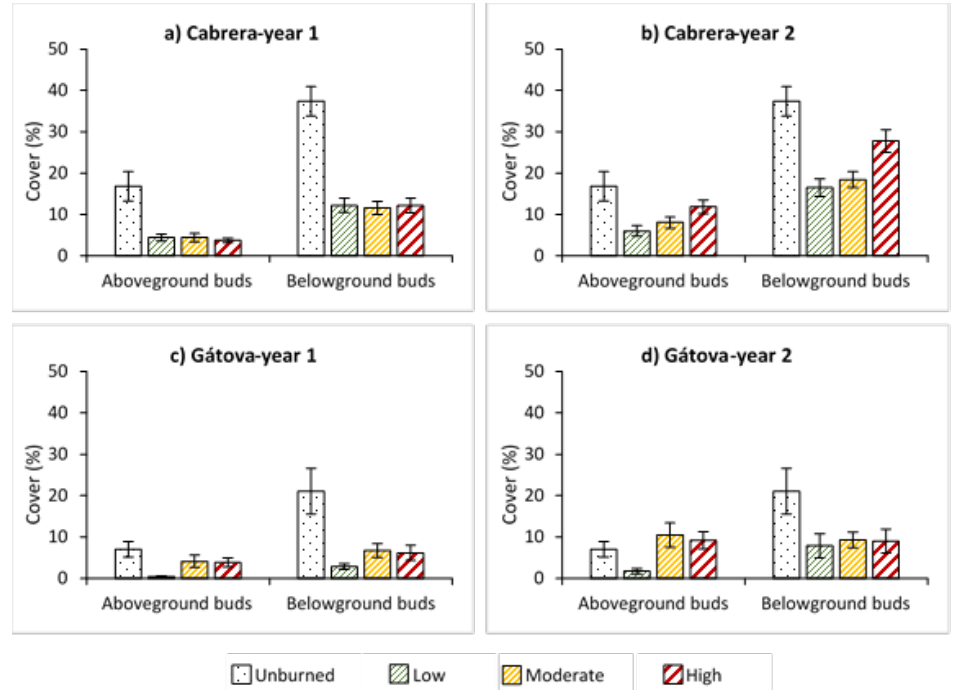
Figure 5. Average cover (%) of species with aboveground and belowground buds, and standard error for each burn severity level (unburned, low, moderate, and high) measured by the composite burn index (CBI) in: ( a ) Cabrera, one year post-fire; ( b ) Cabrera, two years post-fire; ( c ) G á tova, one year post-fire; and ( d ) G á tova, two years post-fire. Statistical information is provided in Tables S3 and S4 (Supplementary Material).